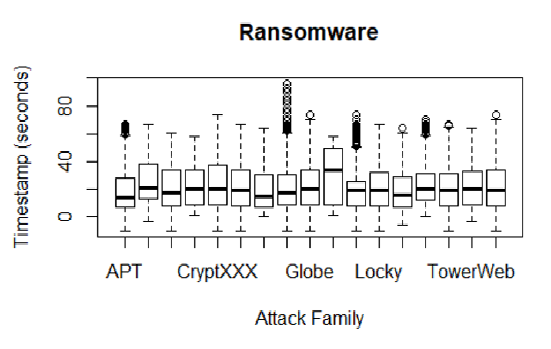
Figure 22. The timestamp of ransomware in the UGRansome